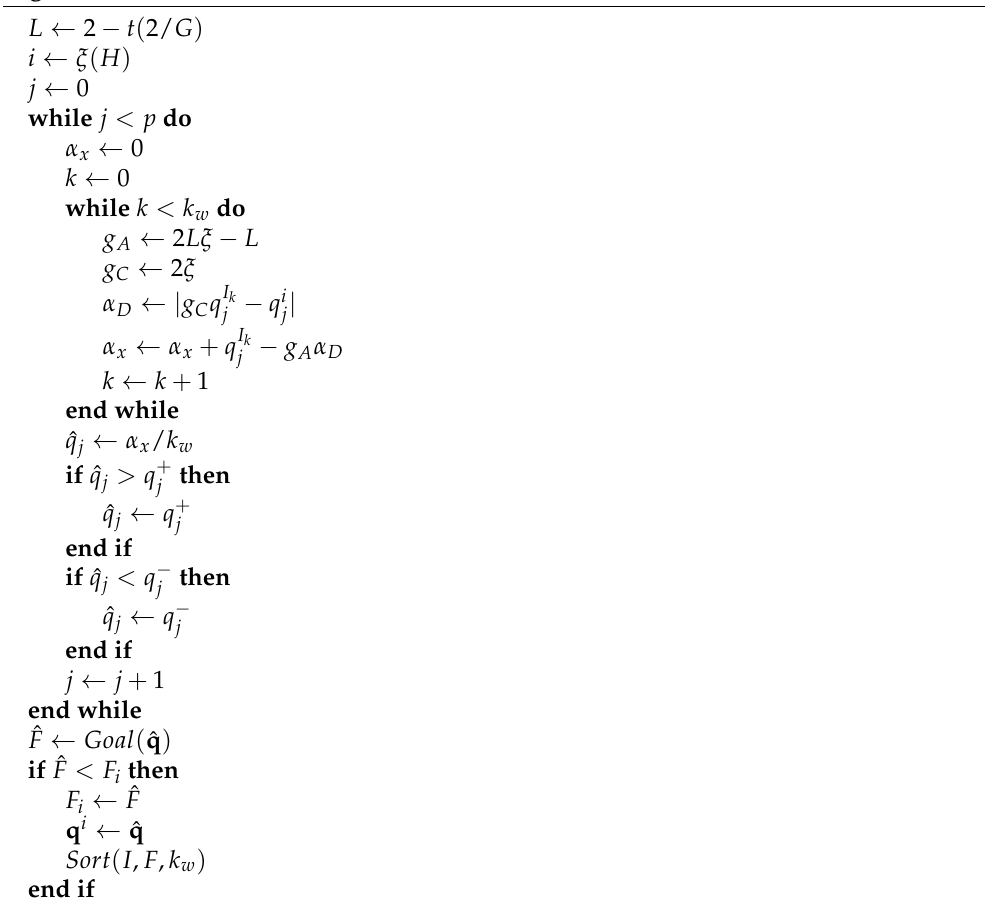
Algorithm A2 GWO